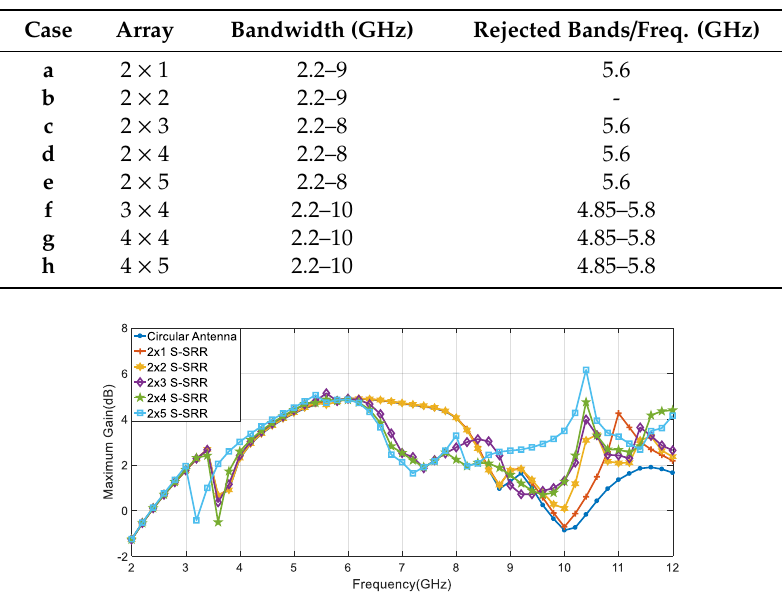
Figure 41. Antennas maximum gain with different S-SRR arrays.